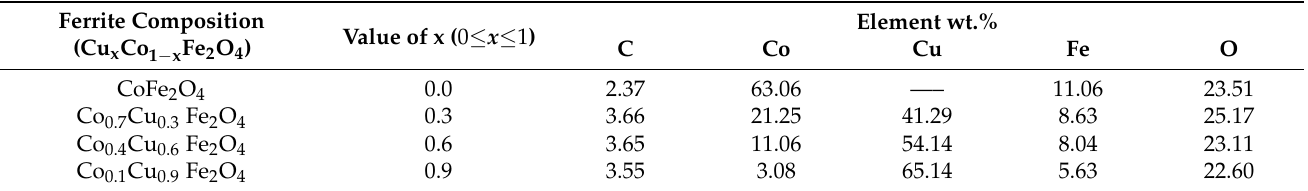
Figure 4. EDX spectra of synthesized, plant-extracted, pure cobalt ferrite nanoparticles at x = 0.0 and Table 1. The elemental composition of plant-extracted pure cobalt ferrite nanoparticles and copper- substituted cobalt ferrite nanoparticles.